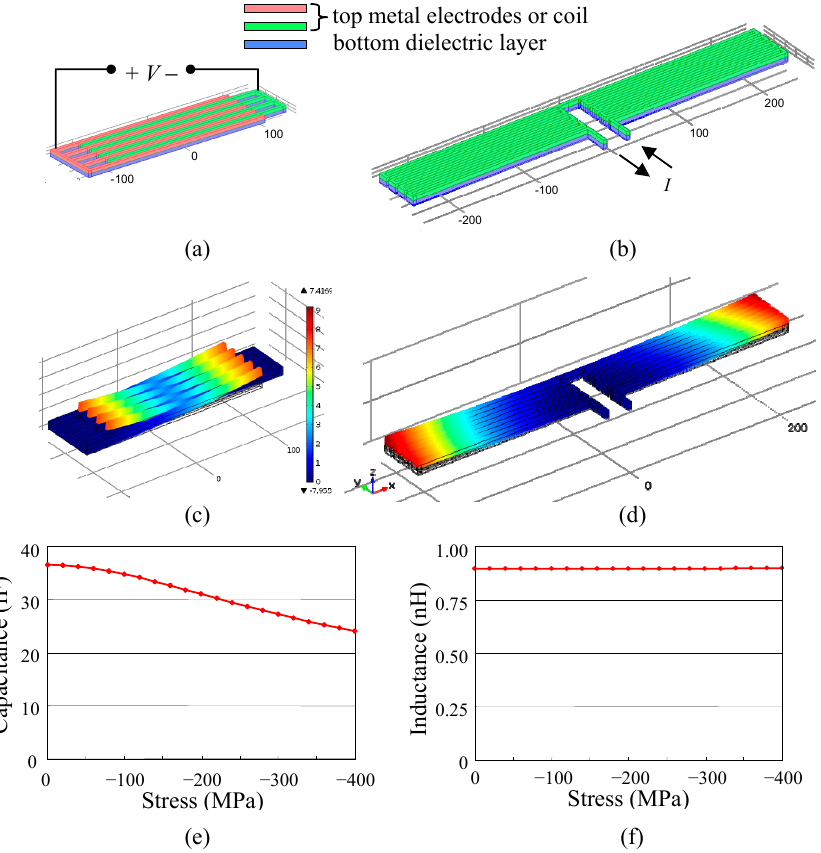
Figure 3. Finite-element-method (FEM) simulation of capacitance and inductance when subjected to residual stress induced deformation: ( a ) Comb finger capacitor, ( b ) meandering sprinductor, ( c ) deformed capacitor at − 200 MPa residual stress, ( d ) deformed sprinductor at − 200 MPa stress, ( e ) capacitance of comb finger capacitance vs. stress, ( f ) inductance of meandering sprinductor vs. stress. Note: (a)–(d) are shown to scale, (c) and (d) are shown with same color scale of total displacement.